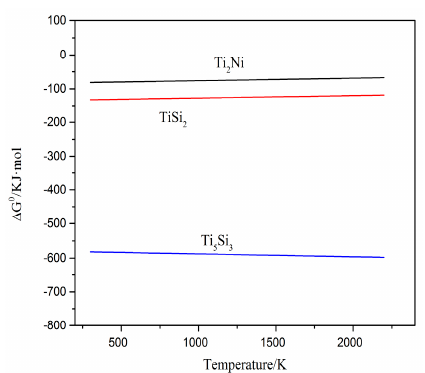
Figure 4. The Gibbs free energy ( Δ G 0 /kJ·mol) of the formation of Ni-Ti-Si compounds.